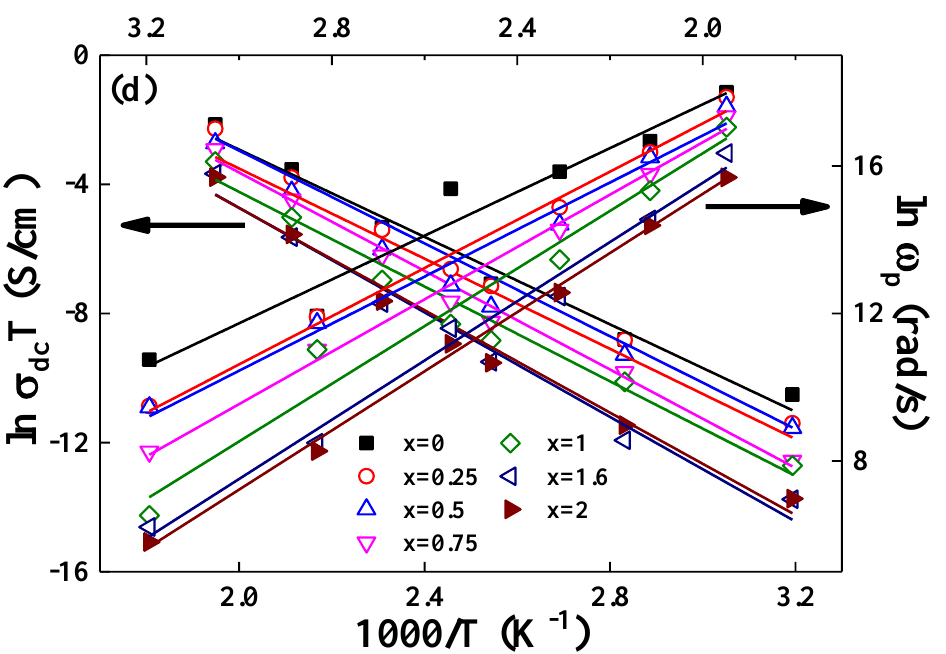
Figure 4. ( a ) Cole–Cole impedance plot of 3Li 2 O-(2-x)Fe 2 O 3 -xMn 2 O 3 -3P 2 O 5 (x = 0, 0.25, 0.5, 0.75, 1.0, 1.6, 2.0) glasses, measured at ambient temperature. The inset shows an equivalent circuit that describes the electrical response of the LM x F 2 − x PO (x = 0.75) glass. ( b ) Temperature-dependent Cole–Cole plot of LM x F 2 − x PO (x = 0) glass. ( c ) Temperature-dependent Cole–Cole plot of LM x F 2 − x PO (x = 1.0) glass. The intersection of the low frequency side of the complex impedance plot with the Z’ axis gives the Z 0 , which is the impedance of bulk at zero frequency. ( d ) Plots of ln σ dc T vs. 1000/T and ln ω p vs. 1000/T. The dc conductivity is taken by 1/Z 0 and the ac relaxation peak frequency ω p is obtained from fit to the imaginary complex impedance Z” ( ω ). The slope of solid lines represents dc and ac electrical activation energies, denoted as E dcC and E acC , respectively.